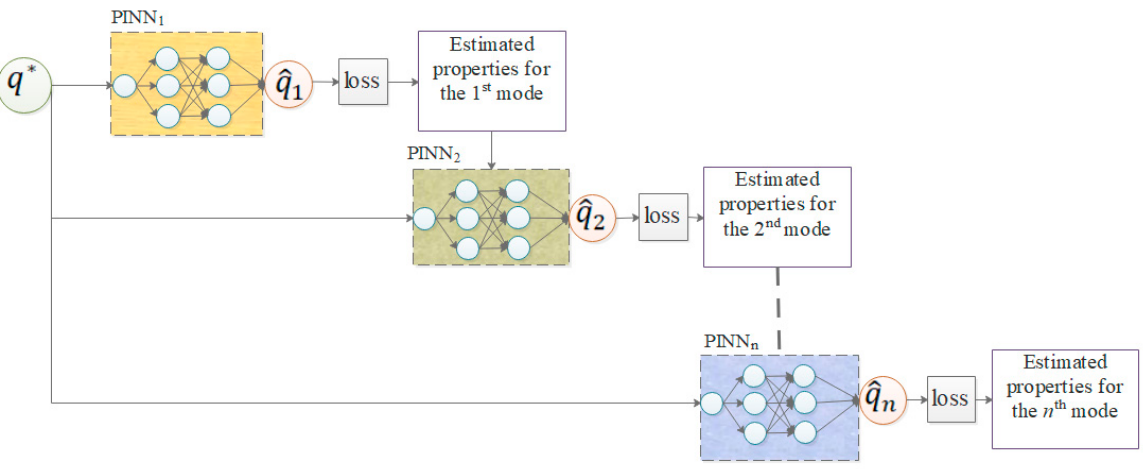
Figure 3. Schematic framework with sequential PINNs.